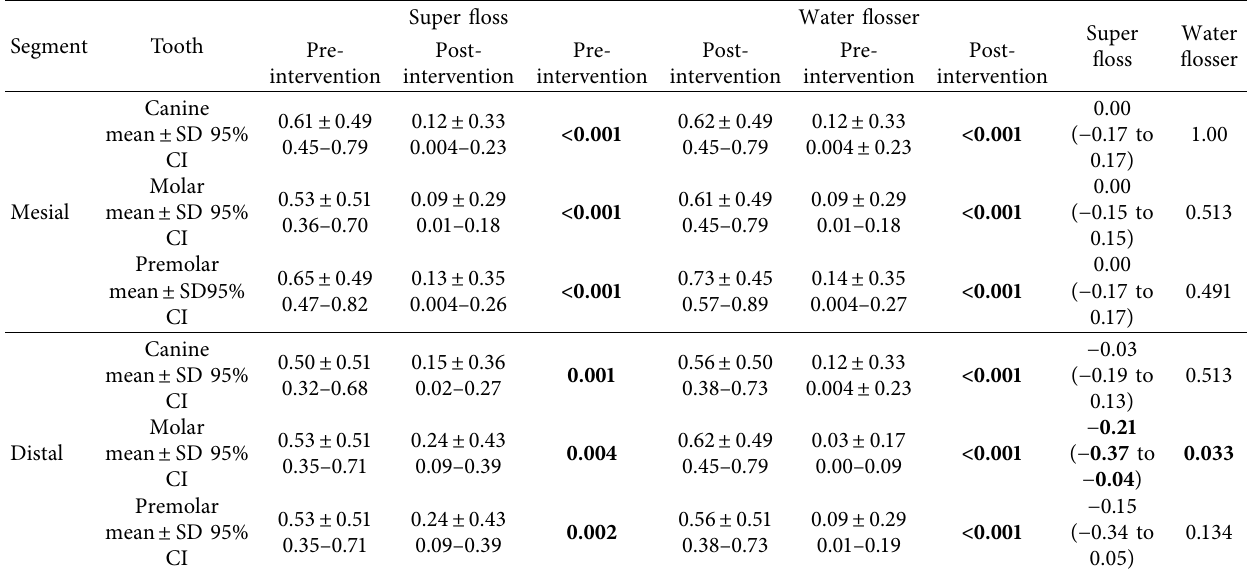
Table 2: Comparison between super floss and water floss pre- and post-cleaning for mesial and distal sides of selected teeth. Segment